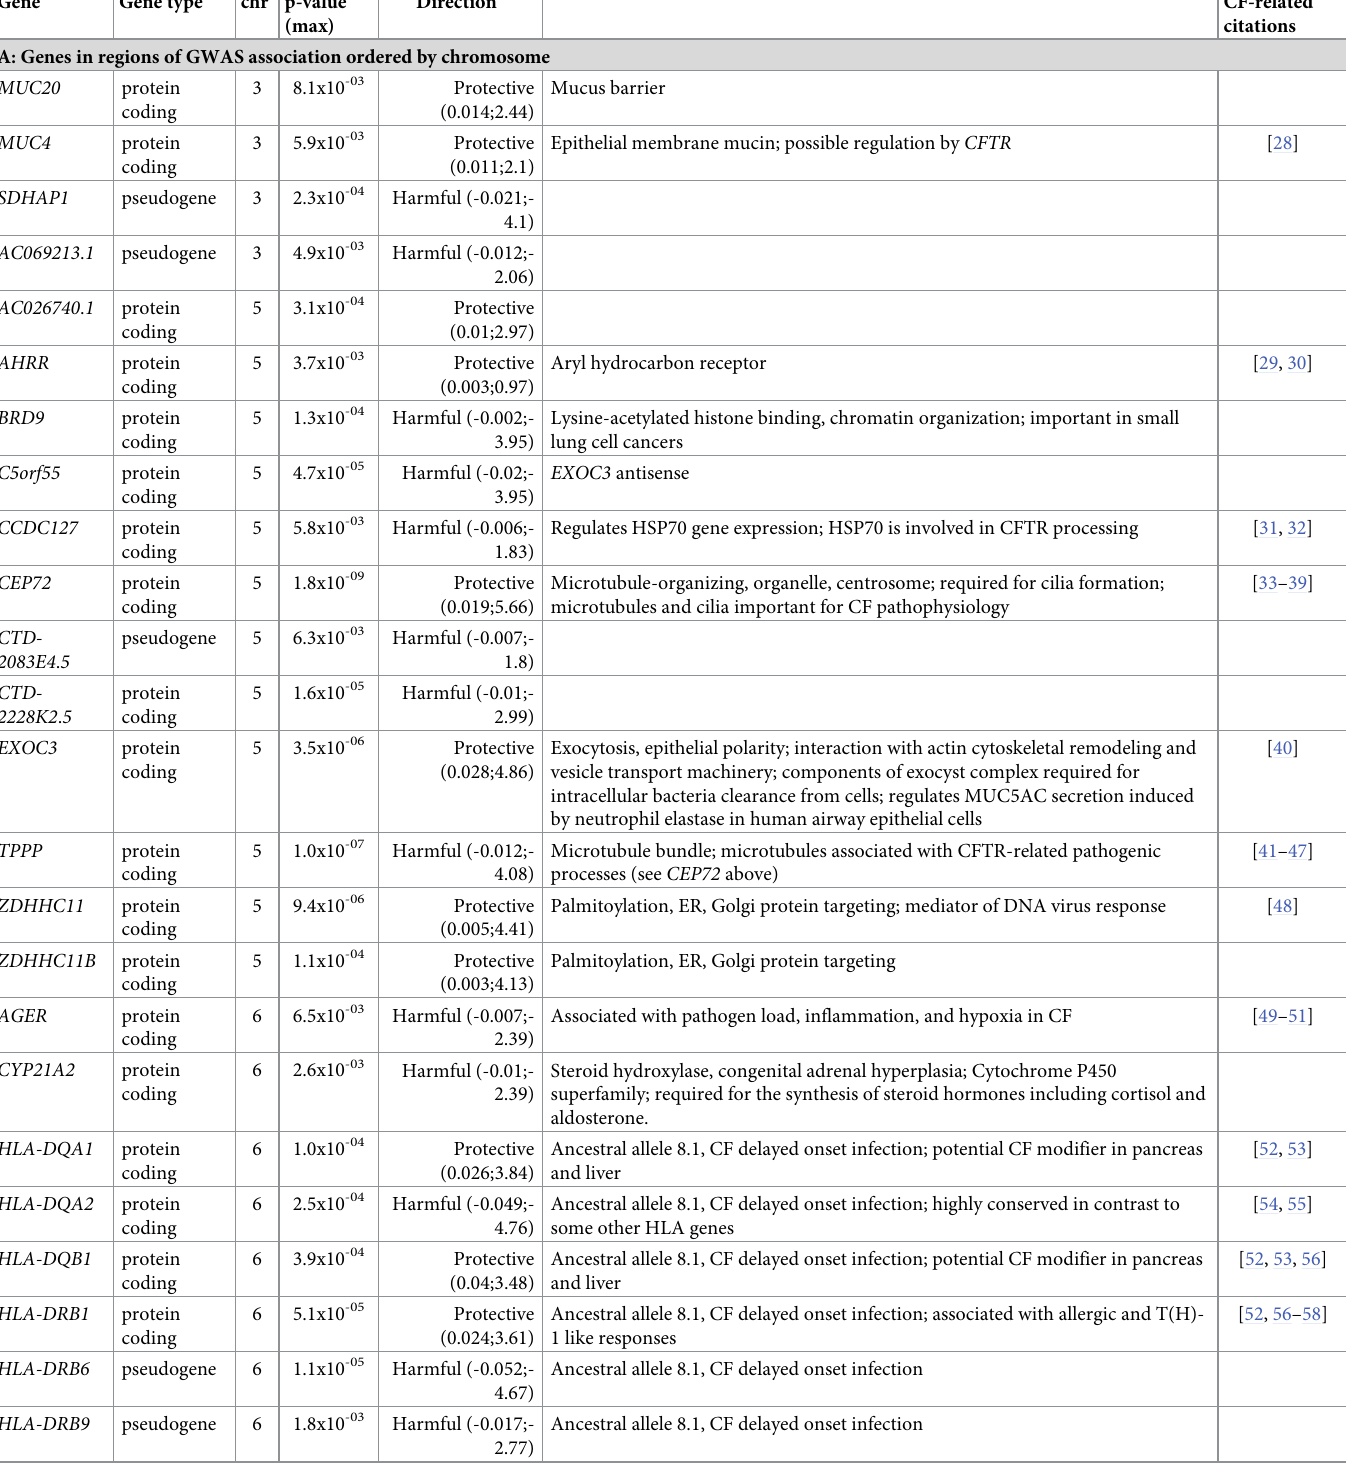
Table 1. Consensus 52 CF lung disease modifier